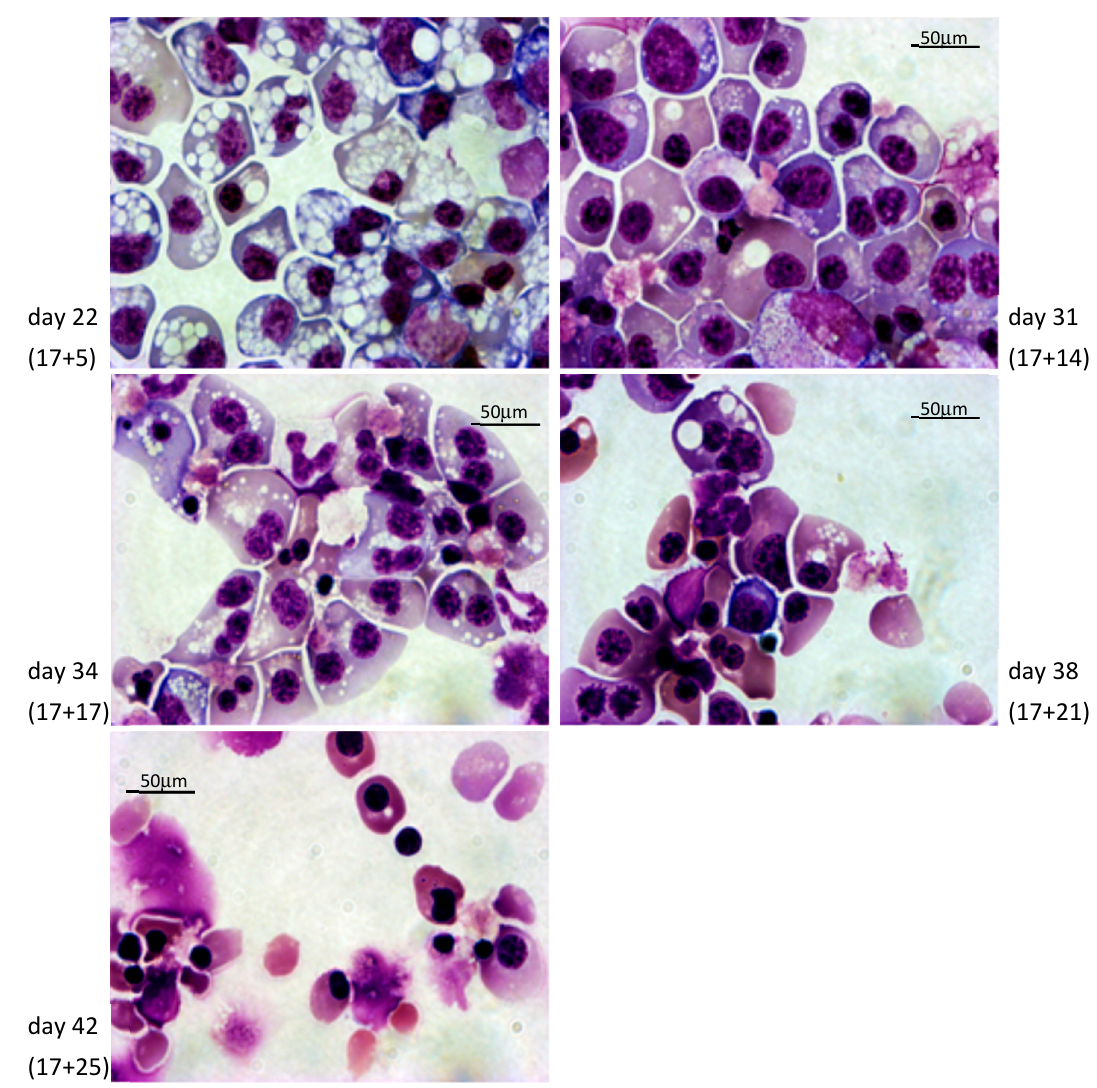
Figure 4. Morphological analysis of baboon iPSCs differentiating into cRBCs using the long PSC-RED protocol: 630x magnification micrograph illustrating the typical morphology of the erythroid cells observed at days 22, 31, 34, 38, and 42 of culture after rapid Romanowsky staining. The majority of cells were pro-erythroblasts at day 22, and orthochromatic erythroblasts and reticulocytes at day 42.